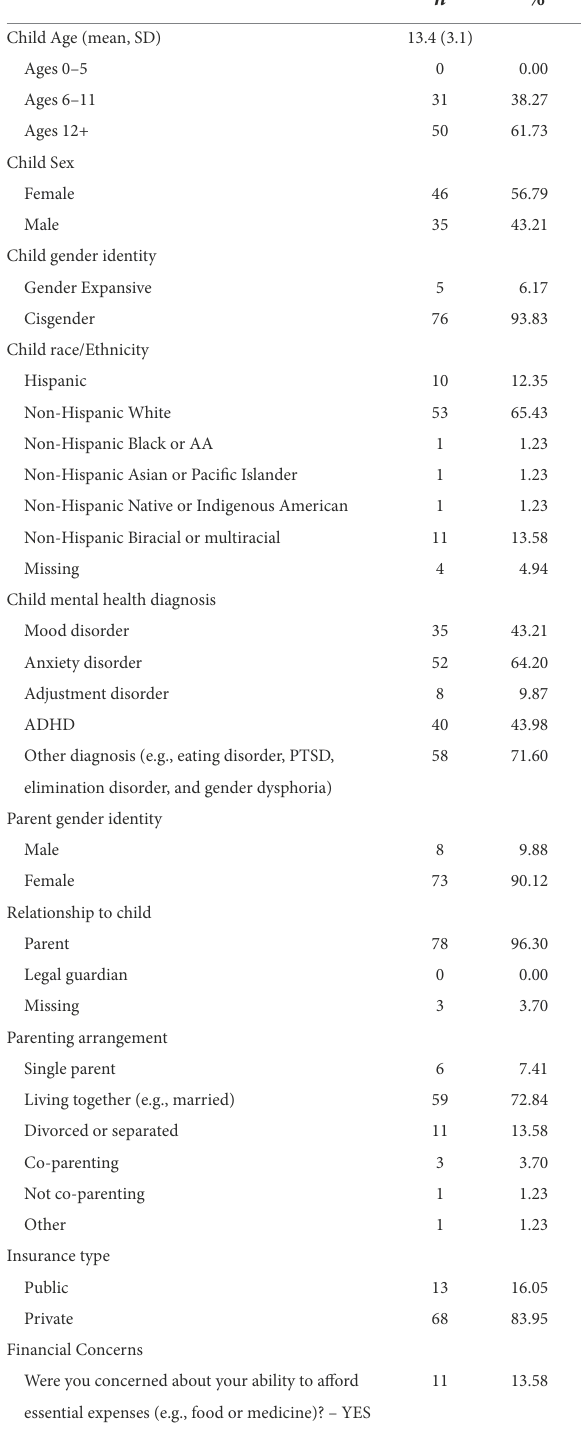
TABLE 1 Child demographics and family characteristics ( N =